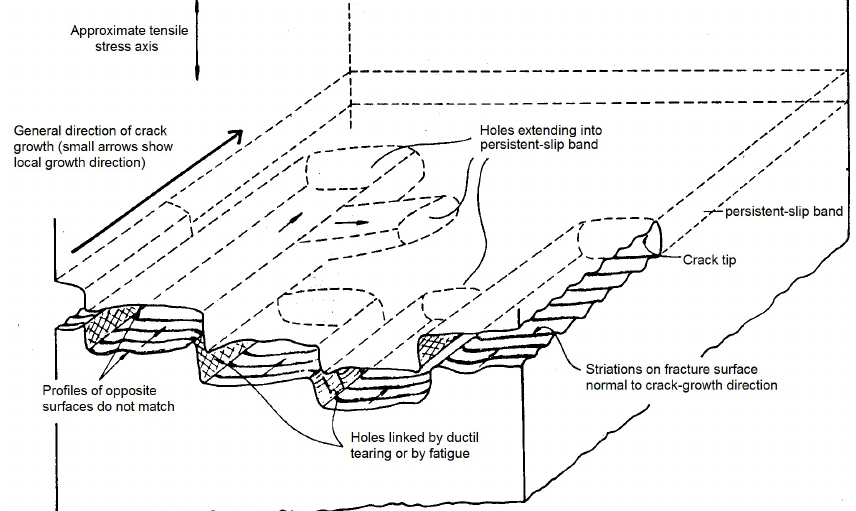
Figure 1: Schema of metals fatigue cracking with simultaneously holes (mesotunnels) formation and crosspieces between them failure because of shearing or fatigue striation creation [6].